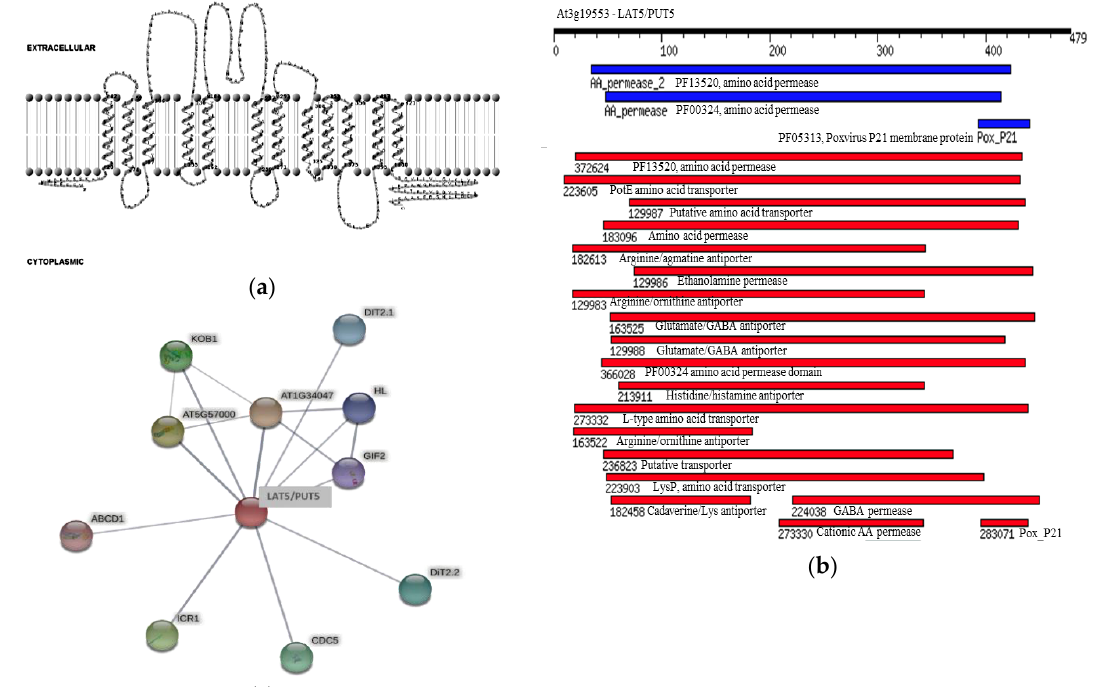
Figure 1. In silico characterization of the Arabidopsis LAT5/PUT5 protein. ( a ) A cartoon representation showing the 12 transmembrane domains in the LAT5/PUT5 protein with both c- and n- termini in the cytoplasmic side. ( b ) Domains conserved in the LAT5/PUT5 protein. The black bar shows the length of the amino acid sequence. The blue and red bars show the position and extent of the domains in LUT5/PUT5 protein. The blue bars show the conserved domains identified in the Pfam database and the red bars show the conserved domains identified in the NCBI conserved domain database. ( c ) Putative physical and functional associations of the LAT5/PUT5 with other proteins. The thickness of the gray line indicates the confidence level of the association between the two proteins. Thicker lines indicate higher confidence.